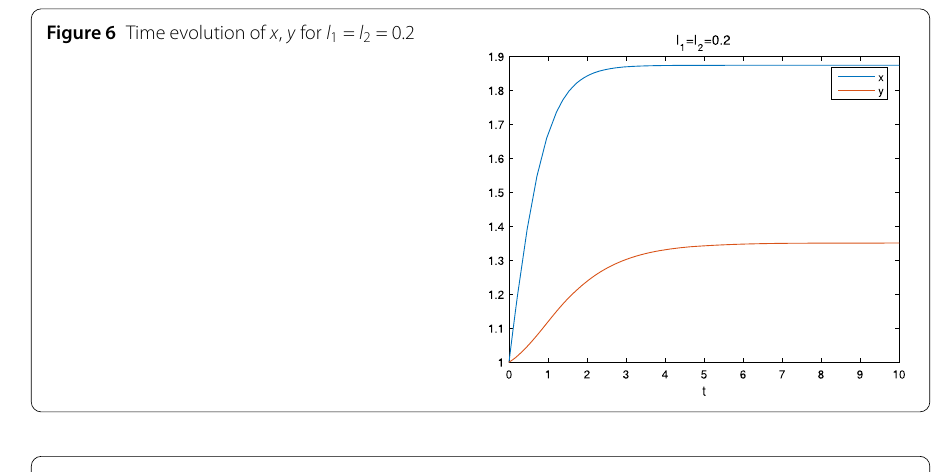
Figure 7 Time evolution of x , y for l 1 = l 2 =